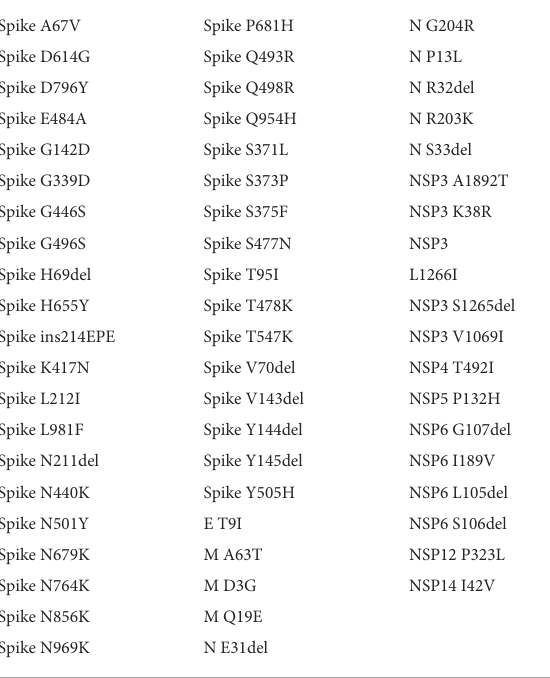
TABLE 2 List of amino acid changes between both variants.